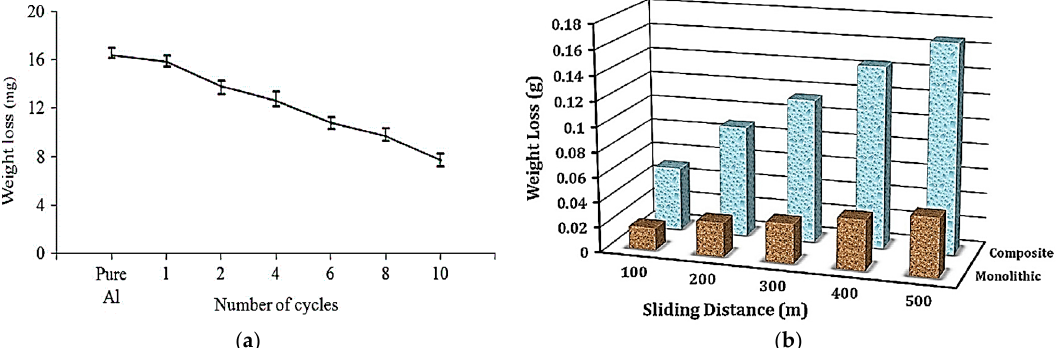
Figure 20. ( a ) Wear behavior of ARBed Al/SiC p nanocomposites processed by different rolling cycles, ( b ) wear behavior of monolithic material and seven-cycle ARBed Al/Al 2 O 3 composite versus sliding distance [127].